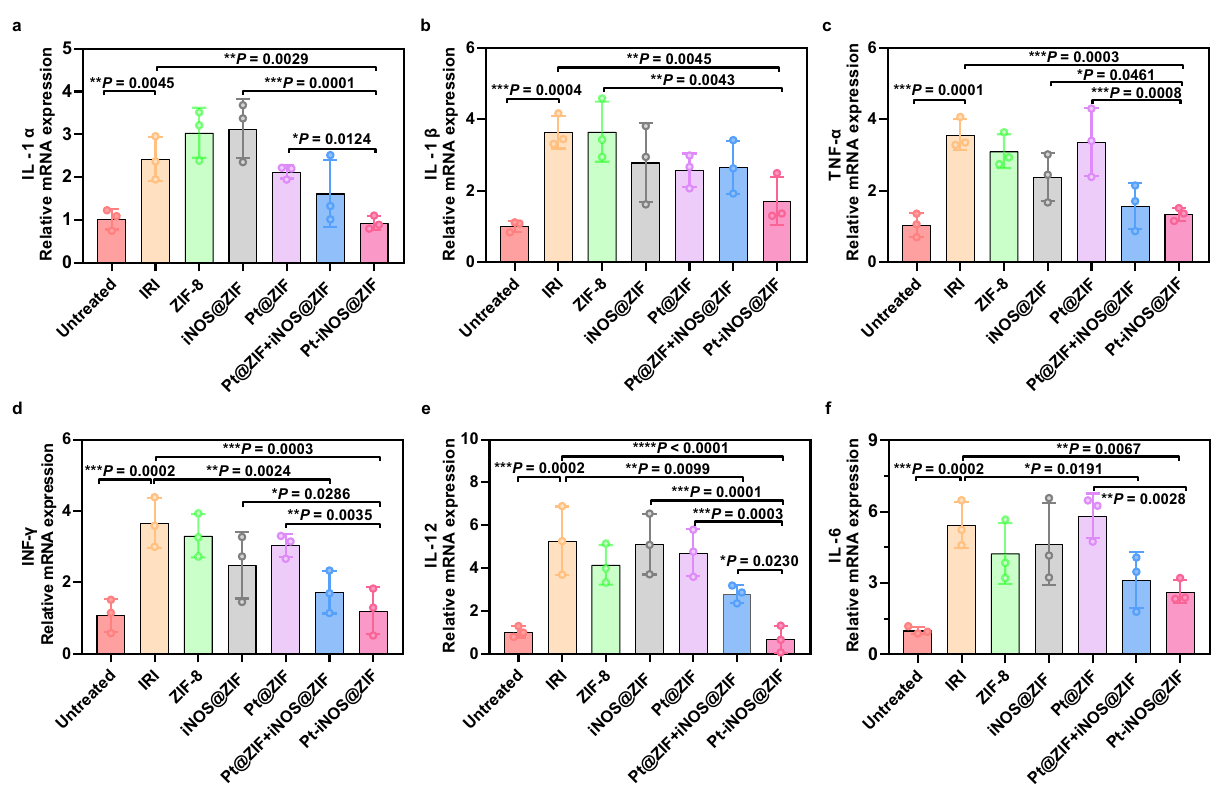
Fig. 7 Anti-in fl ammatory activities in hepatic IRI. Relative expression of mRNAs for cytokines of IL-1 α ( a ), IL-1 β ( b ), INF- γ ( c ), IL-12 α ( d ), TNF- α ( e ), IL-6 ( f ) ( n = 3 biologically independent animals). Data presented as means ± s.d. from three independent replicates, and P values were calculated by ANOVA F - test, each comparison stands alone. * P < 0.05; ** P < 0.01, *** P <